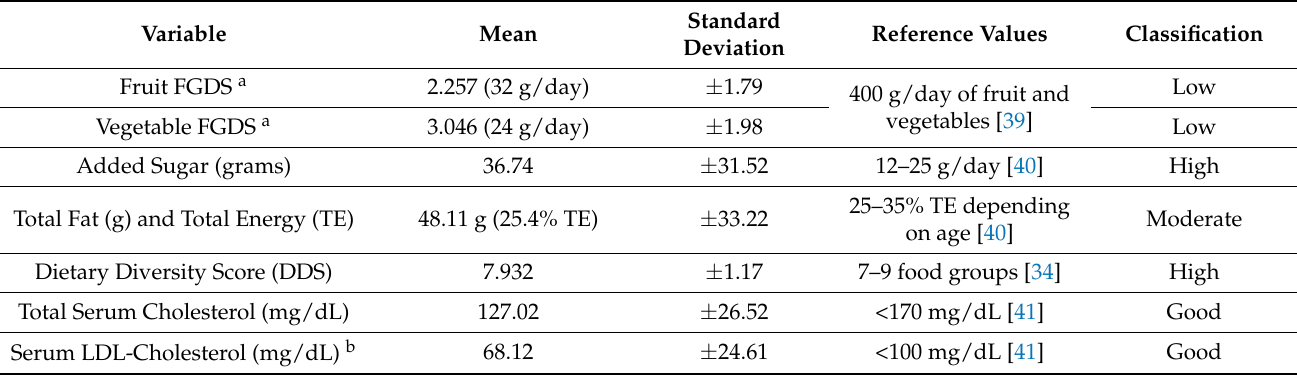
Table 1. Descriptive statistics for observed variables.